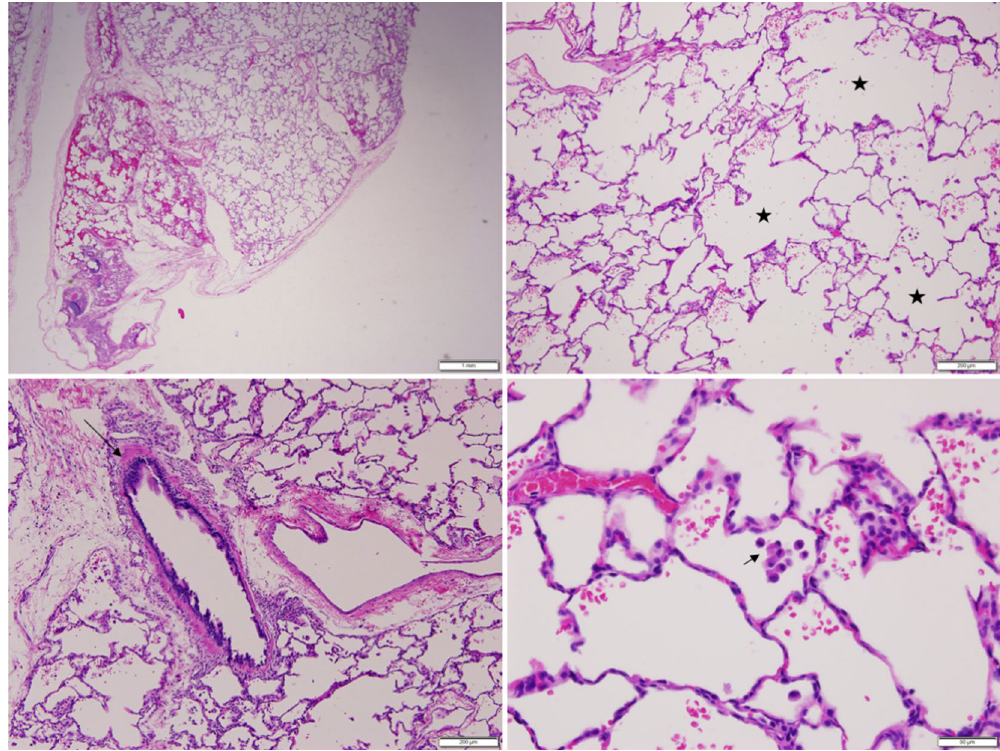
Figure 4. Lung (left lower lobe) biopsy at 18 months of age in the child with homozygous MUC5B :c.16861G > T, p.Glu5621*. Hematoxylin and eosin stain showing diffuse enlargement and simplification of the airspaces with thin alveolar septae (stars), mild interstitial fibrosis (long thin arrow), and intra-alveolar macrophages (short thin